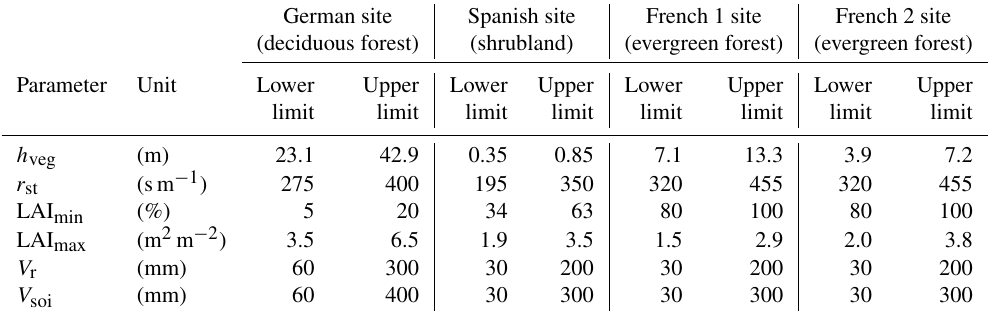
Table 3. Site-specific constrained parameter ranges at the four FLUXNET sites for the vegetation parameters ( h veg , r st , LAI min , LAI max and V r ) and the soil storage capacity ( V soi ). More information on how the ranges were determined is provided in Sect. S3 of our Supplement. Parameters are defined in Table